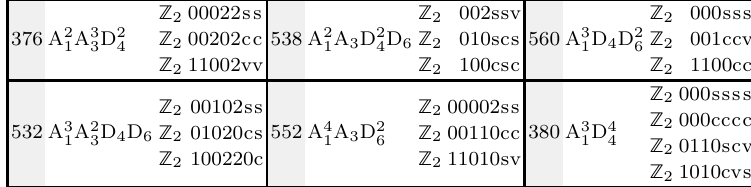
Table 9 . Groups of maximal rank with non-trivial fundamental group and their generators for the heterotic string on T 3